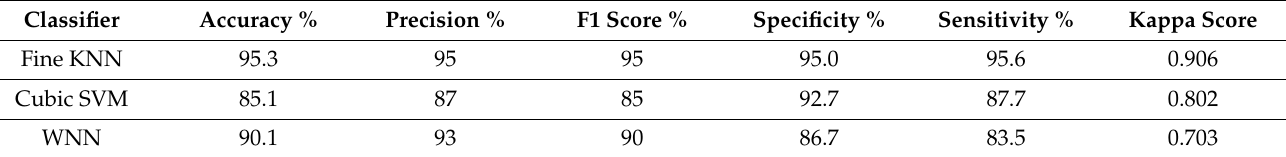
Figure 4. Confusion matrix on five-fold validation. ( a ) Fine KNN; ( b ) WNN; ( c ) SVM-cubic. The computed classification outcomes are shown in Table 3. Table 3. Classification results on MURA elbow fracture dataset using five-fold validation.